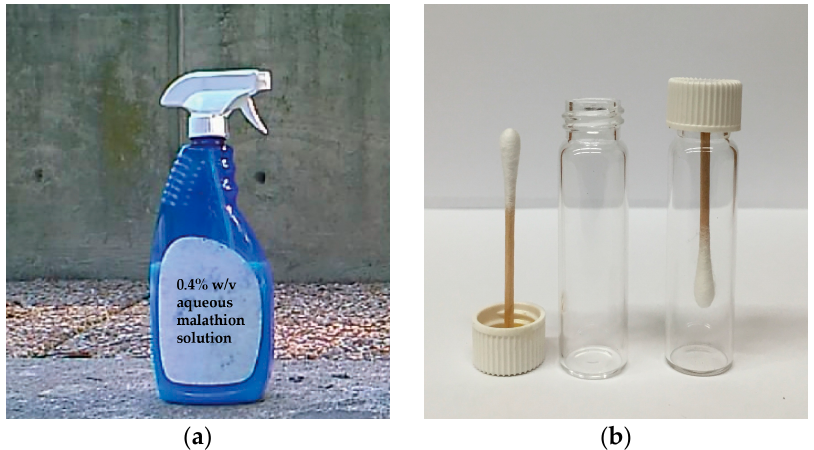
Figure 1. Illustration of the sampling method: ( a ) About 1.3 ± 0.1 mL of aqueous 0.4% w / v malathion solution was sprayed from approximately 30 cm distance from a household spray bottle (foreground) by a single application of the lever onto a concrete wall in the background; ( b ) After swabbing the surface across the sprayed area using cotton-tipped applicators with their wooden handle glued in scintillation-vial caps (on the left ), the swabs were screwed into the vials (on the right ) to protect from sample loss and cross-contamination.